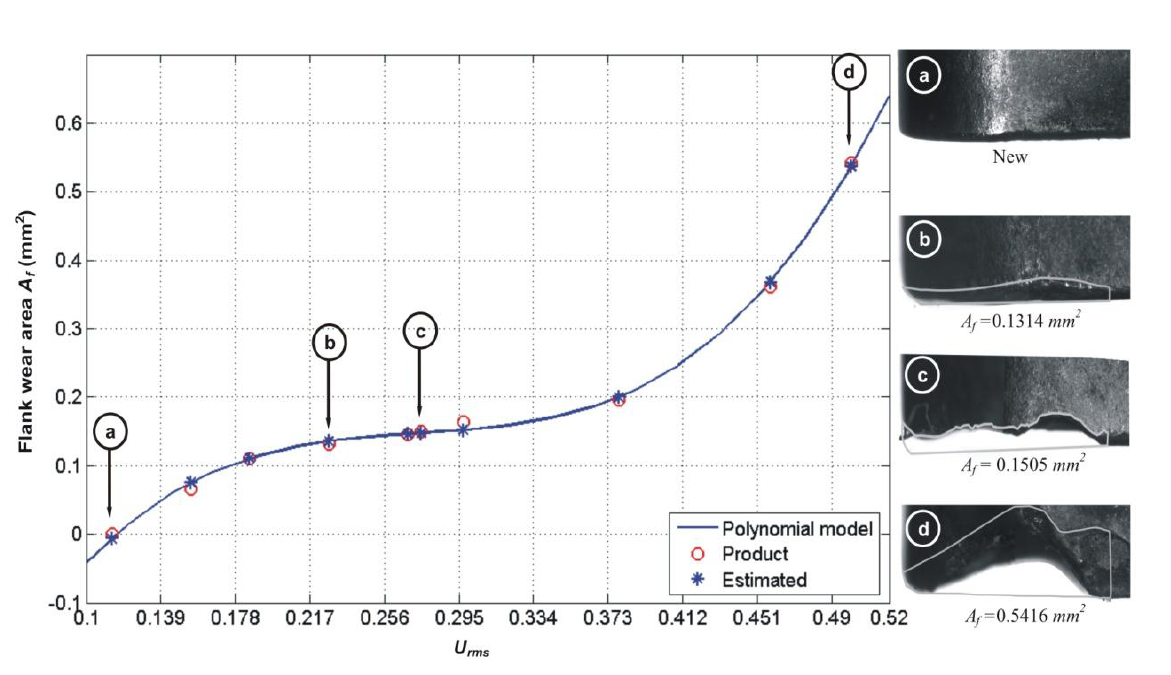
Figure 9. Flank-wear area estimation based on the fused smart-sensor methodology.